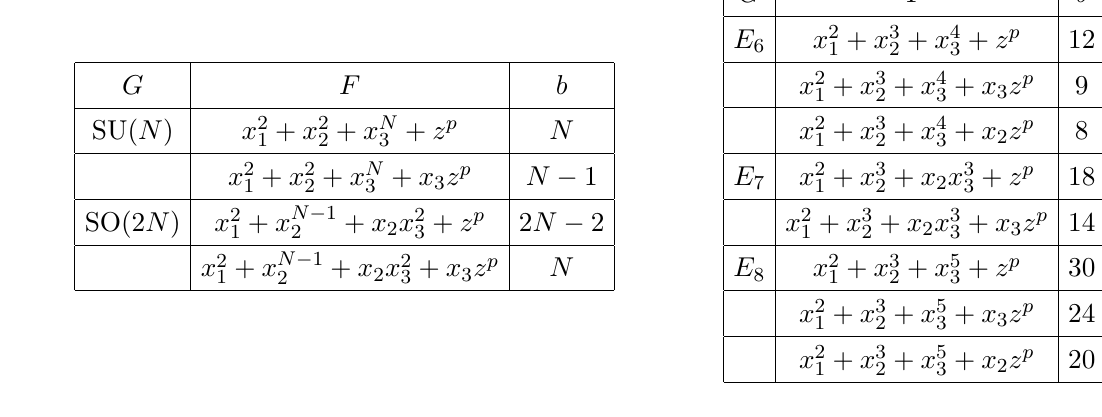
( G ) theories in Type IIB string theory, p